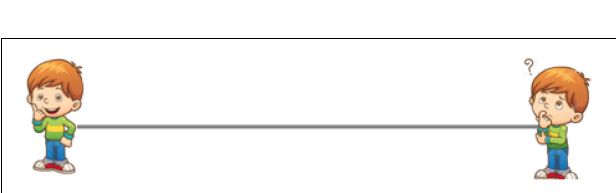
FIGURE 5 | Pictorial illustration of the mental effort scale for children (from very low mental effort – at left – to very high mental effort – at right).